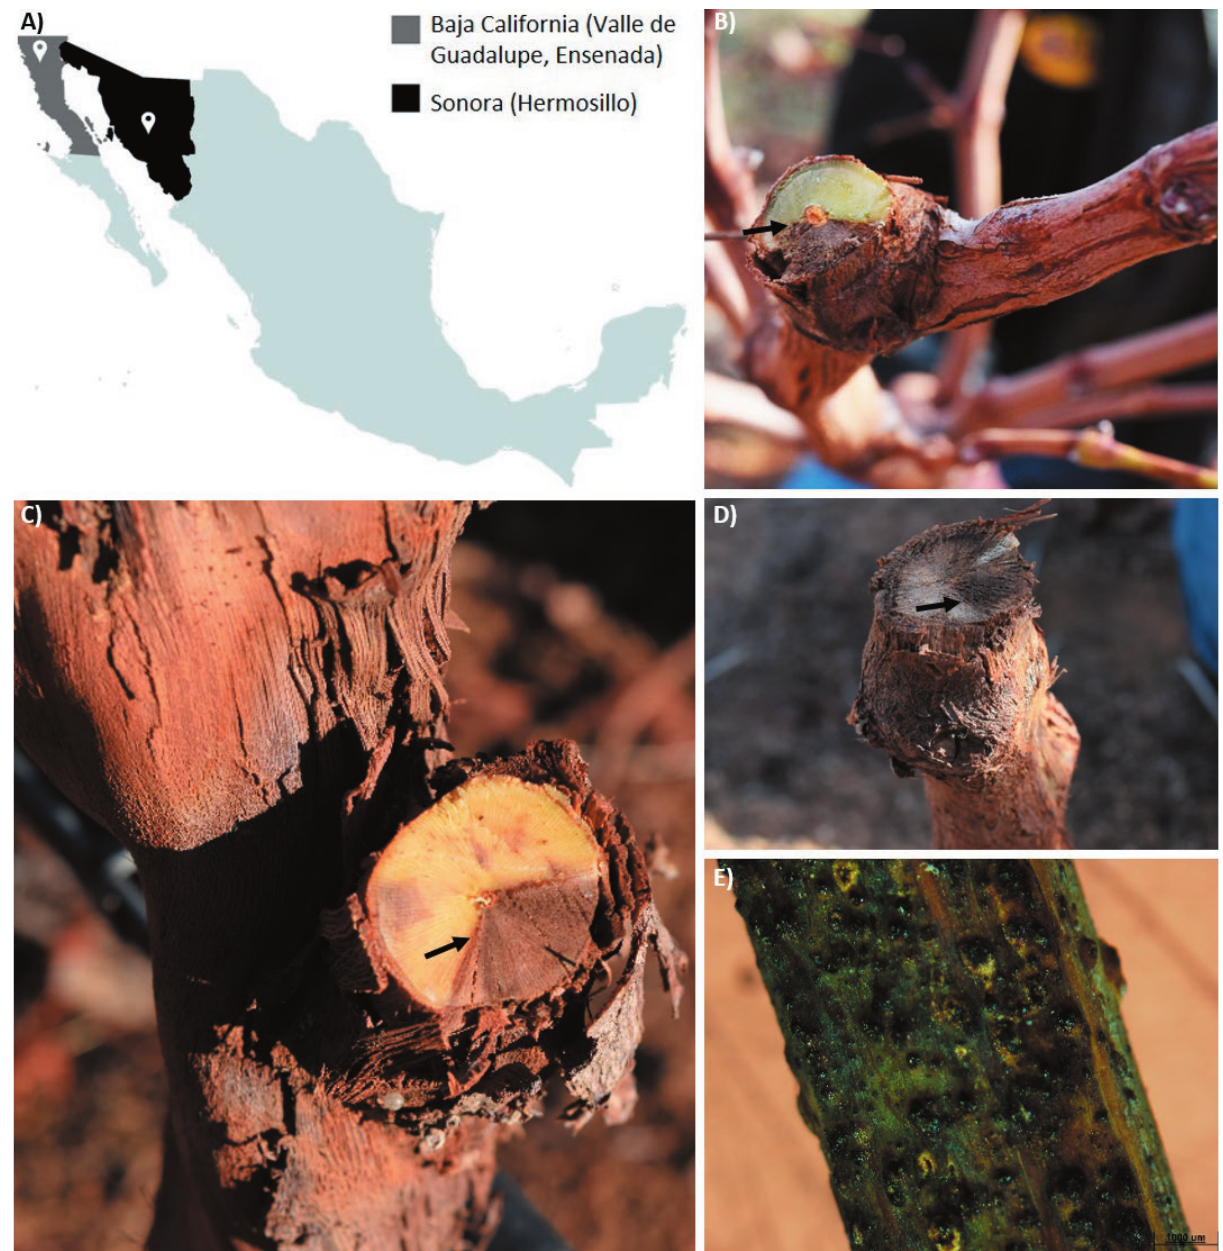
Figure 1. Locations of study sites and symptoms of Botryosphaeria dieback in Vitis vinifera associated with Lasiodiplodia spp. A) Field study sites in Baja California and Sonora regions. B-D) Grapevine plants showing vascular necroses, wedge-shape cankers and wood necroses. E) Pycnidia observed under a stereoscopic microscope found in some grapevine